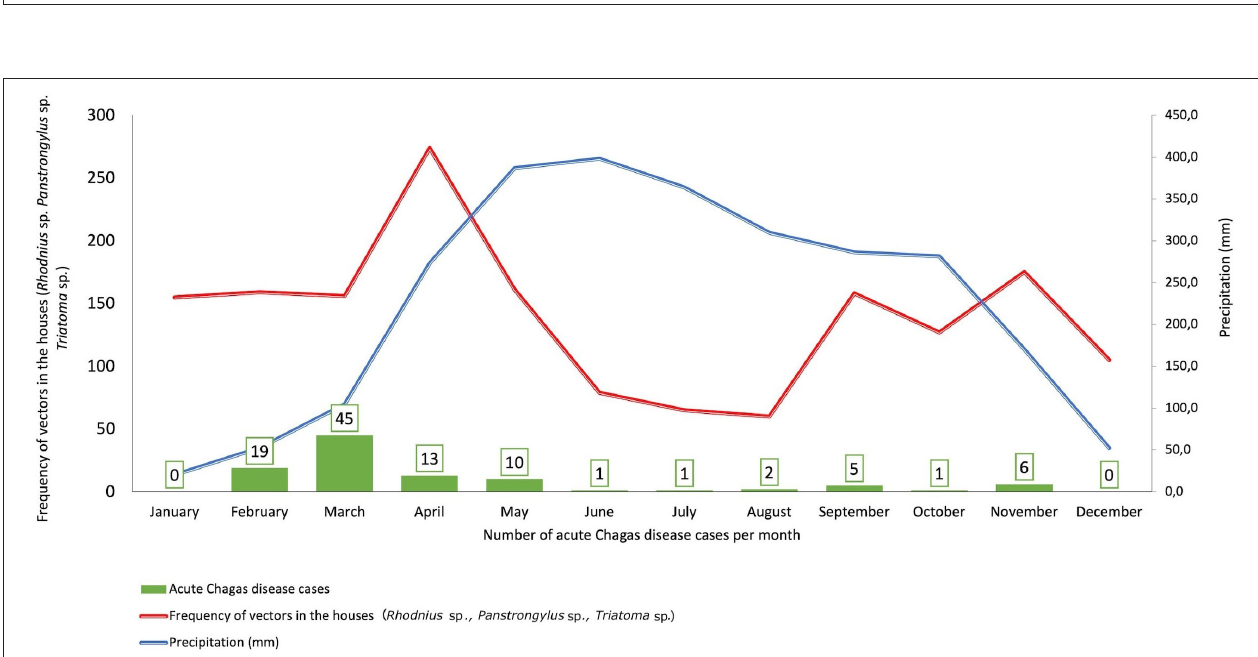
FIGURE 5 | Climatic conditions, frequency of vectors by community surveillance vs. Number of Acute Chagas disease cases, Casanare 2012–2020.